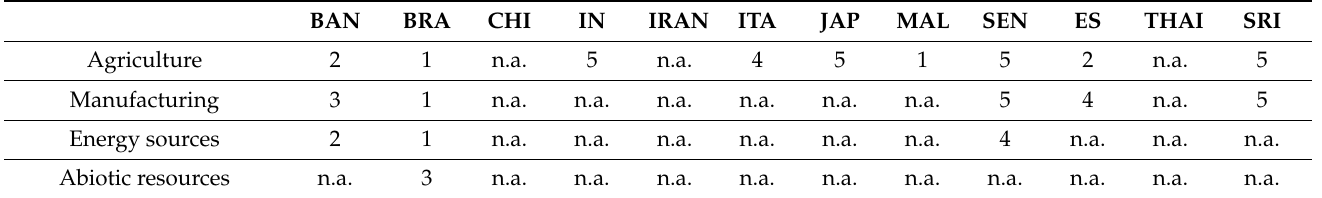
Table 3. Discrimination: risk of inequal wage (score 1 = very low risk, 5 = very high risk, n.a. = not available) [69].